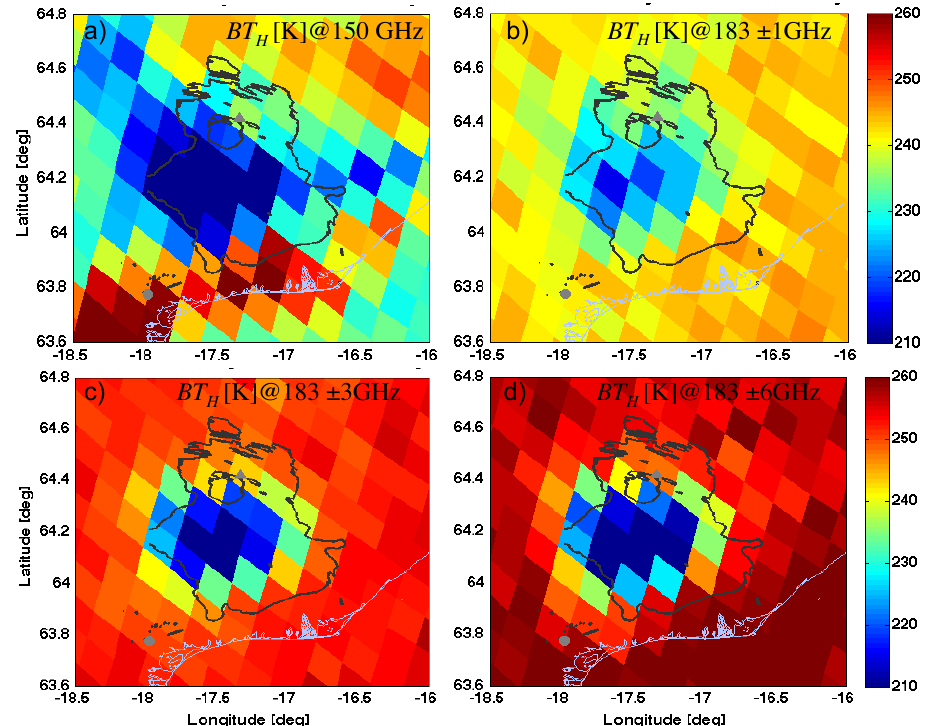
Fig. 7. Maps of brightness temperature at horizontal polarization (BT H ) in Kelvin taken from the Special Sensor Microwave Imager/Sounder (SSMIS) carried aboard of the Defense Meteorological Satellite Program (DMSP) F-17. Data were acquired at 07:15UTC on 22 May 2011 in the surrounding of the Grímsvötn. (a)–(d) show BT H s at 150, 183 ± 1, 183 ± 3 and 183 ± 6GHz, respectively. Contours of the radar reflectivity at 5 and 30dBZ are shown using black lines. The radar and the volcano vent positions are indicated with the symbols “O” and “ 1 ”, respectively. Coast lines are indicated by bright grey